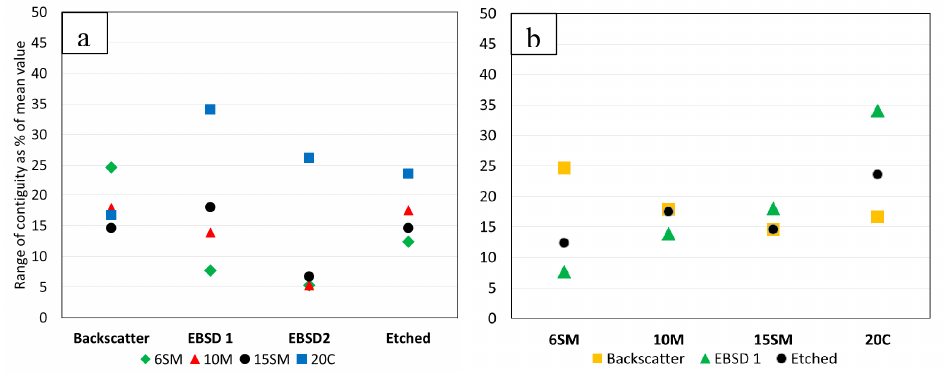
Figure 8. Variability in contiguity ( a ) as a function of the method and ( b ) as a function of hardmetal grade.